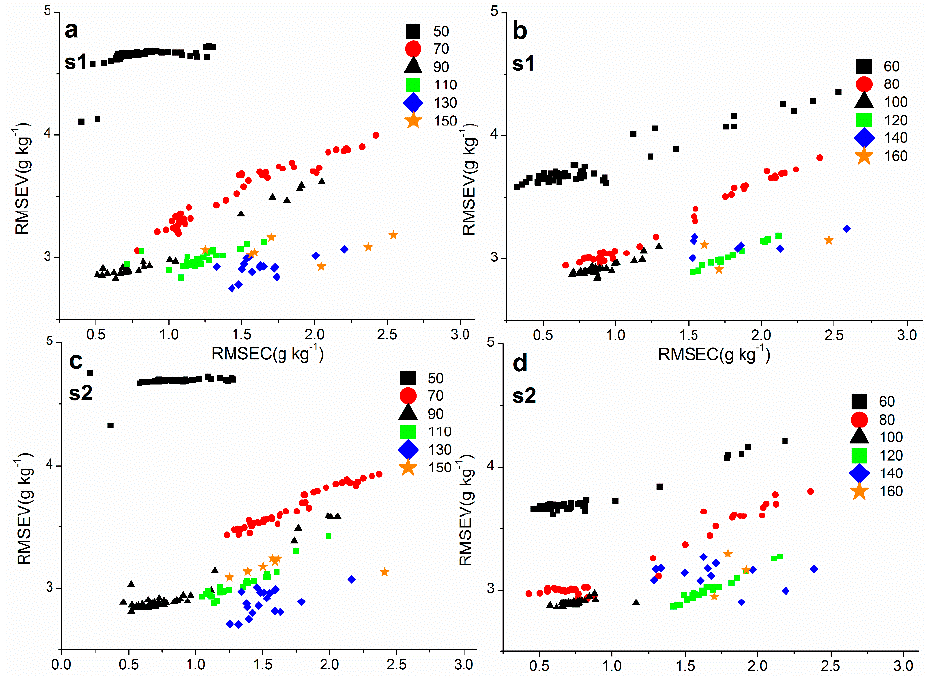
Figure 5. Root mean square error of validation (RMSEV) versus root mean square error of calibration (RMSEC) obtained by regressor s1 ( a , b ); and RMSEV versus RMSEC obtained by regressor s2 ( c , d ) in Co-LSSVMR training phases when more than 50 labeled samples are used in calibration.